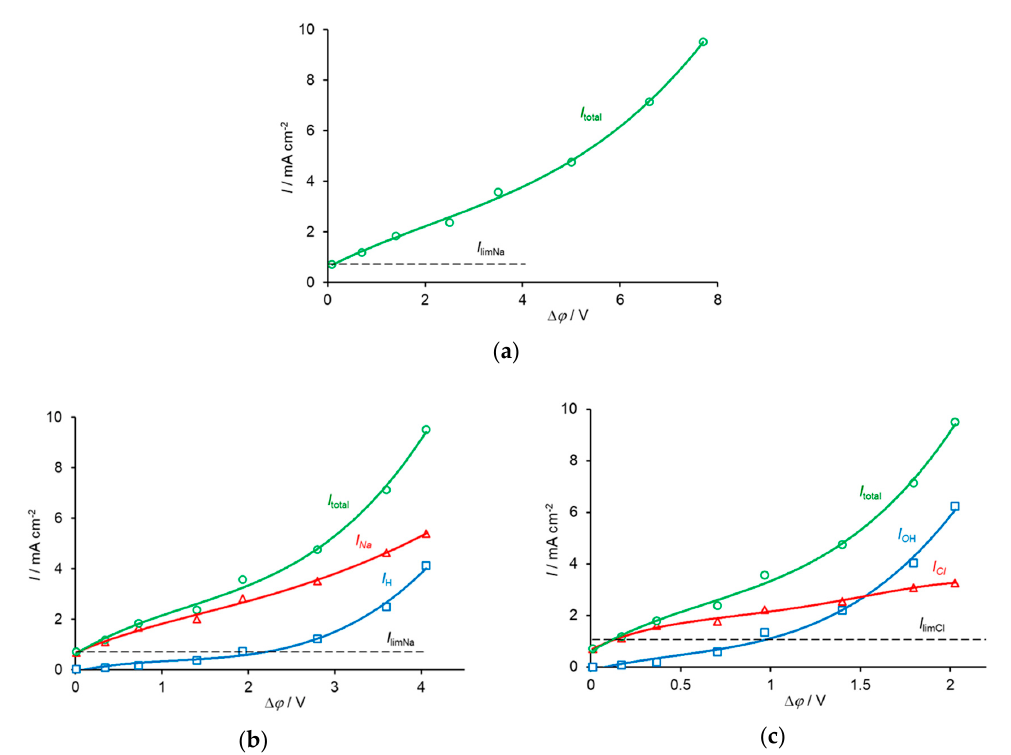
Figure 2. Current–voltage curves for a desalination compartment formed of a MA ‐ 40 anion ‐ exchange membrane and a MK ‐ 40 cation ‐ exchange membrane. The potential drop across both membranes ( a ) refers to points 1 and 2 in Figure 1a; that across the MK ‐ 40 membrane ( b ), to points 3 and 2; that across the MA ‐ 40 membrane ( c ), to points 1 and 3. In the case of individual membranes, the potential drop in the bulk solution was subtracted. The total and partial currents of the Cl − and OH − ions through the MA ‐ 40 membrane and Na + and H + ions through the MK ‐ 40 membrane are shown. The symbols show the experimental data taken from [72]; the lines are a guide to the e у e. The membranes form a cell ‐ pair in an ED cell, schematically shown in Figure 1a. The active membrane area was 3 cm × 3 cm, the distance between the membranes was 0.1 cm. A 0.002 M NaCl solution with an average velocity of 3.2 cm ∙ s − 1 passed between the membranes. The potential drop across the cell ‐ pair was measured using two Luggin capillaries whose positions are shown with points 1 and 2 in Figure 1b. The total and partial current densities of the Na + and H + ions through the MK ‐ 40 membrane and those of the Cl − and OH − ions through the MA ‐ 40 membrane were found [72]